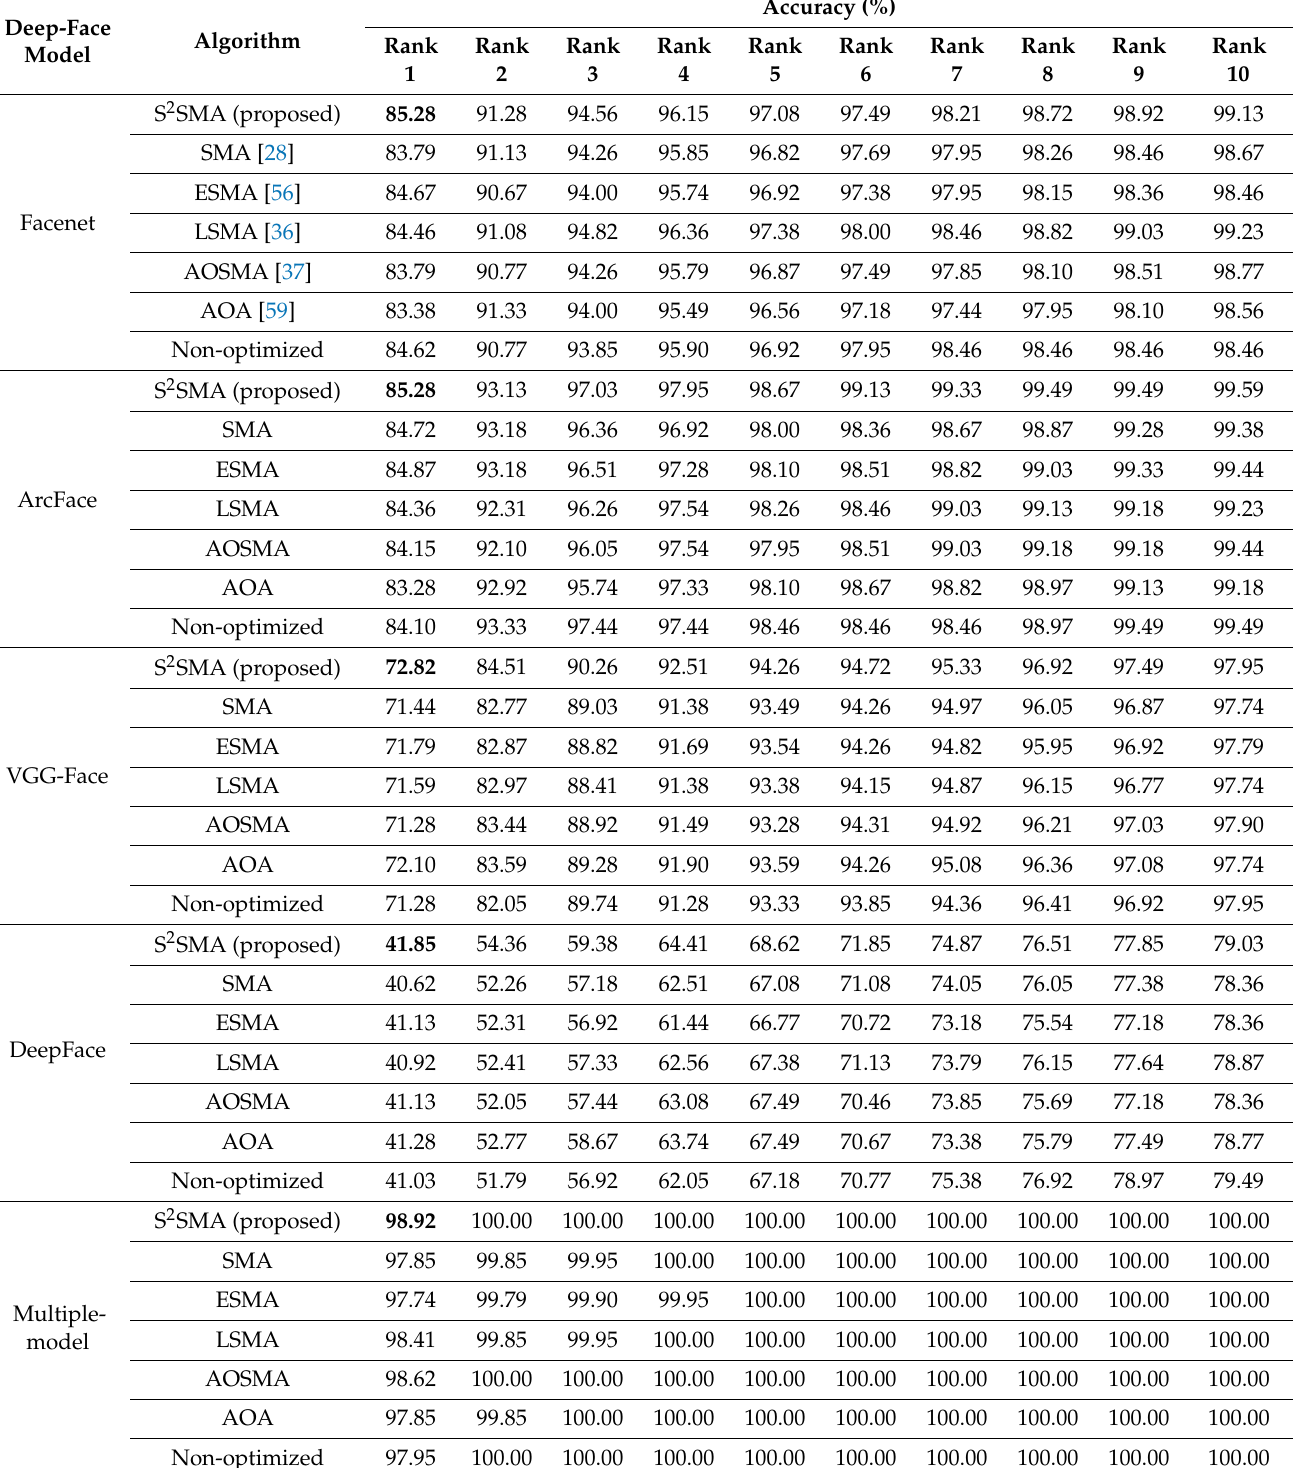
Table 9. A comparison of the effectiveness of several optimization algorithms and a non-optimized model on